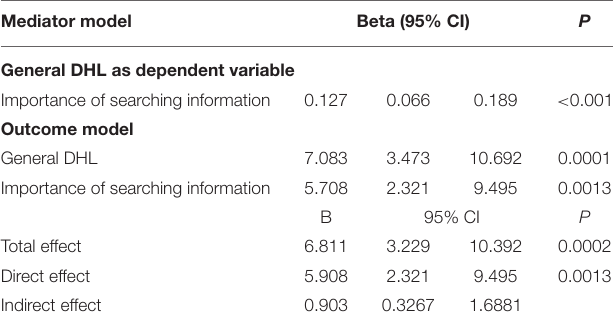
TABLE 4 | Digital health literacy as a mediator of the relationship between the importance of searching information and subjective